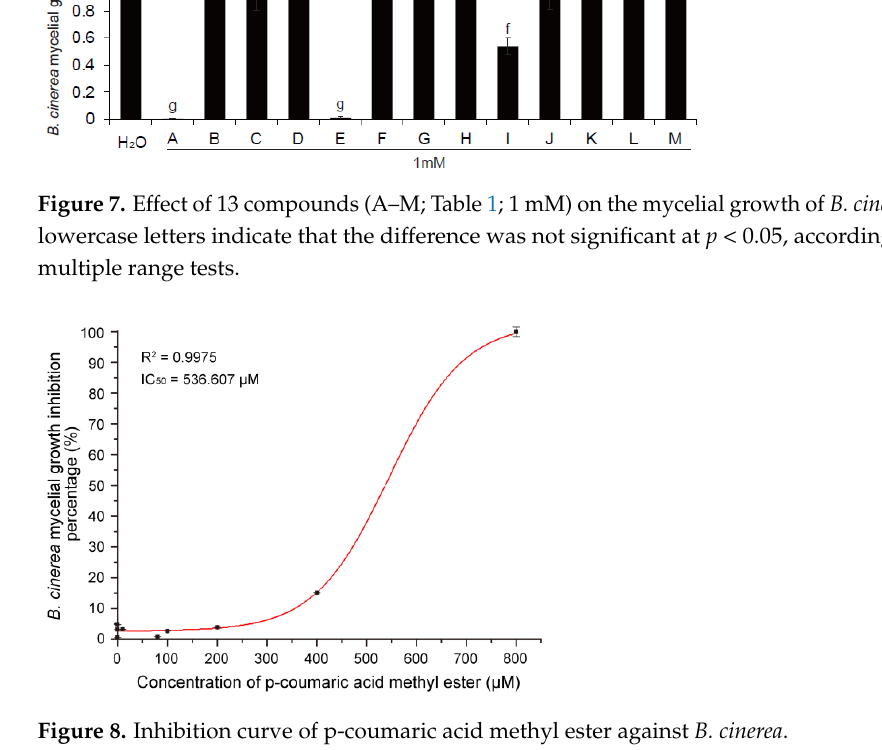
Figure 8. Inhibition curve of p-coumaric acid methyl ester against B. cinerea .